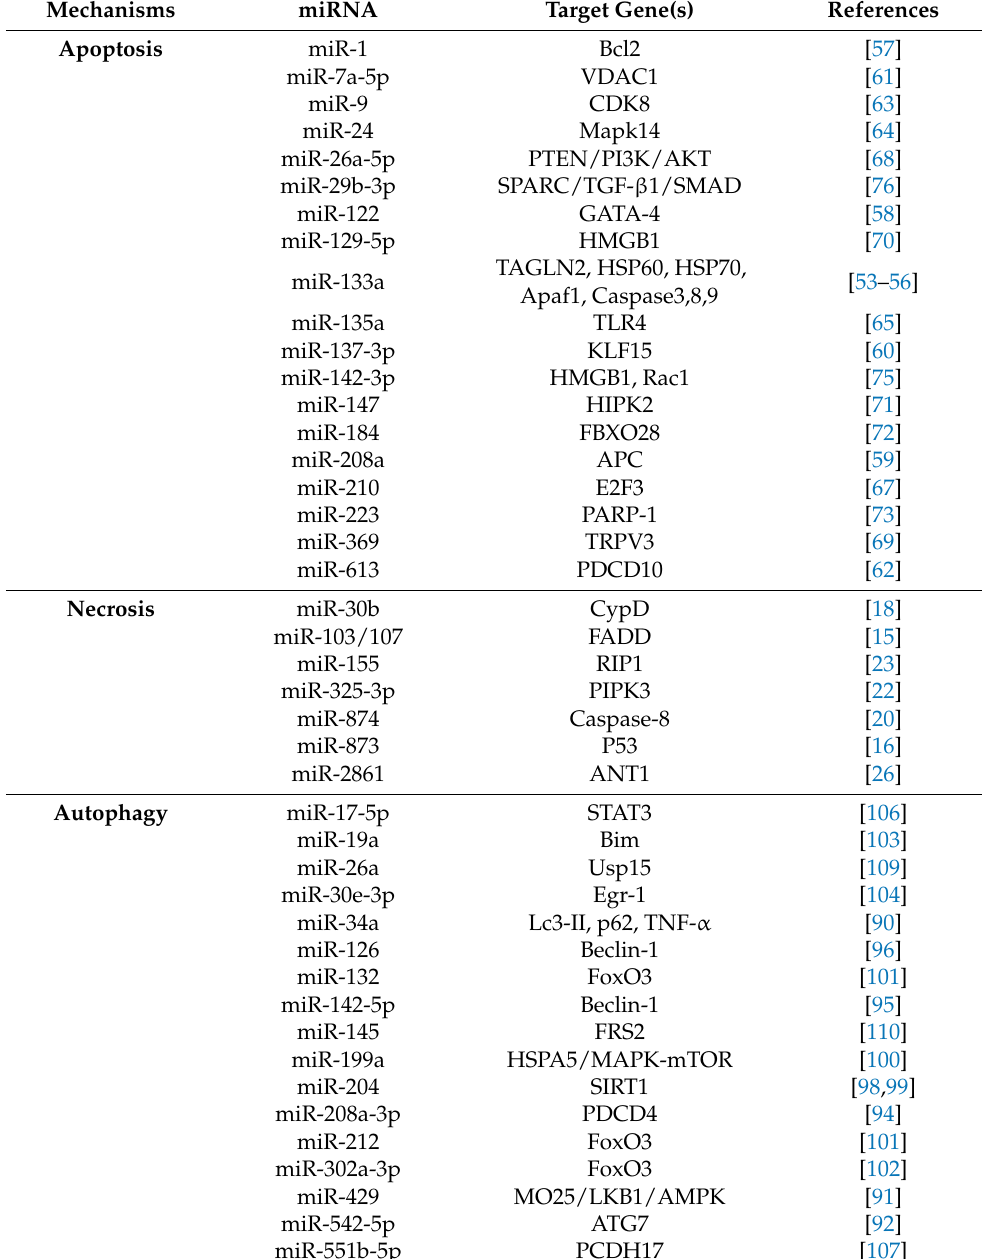
Table 1. Main miRNAs linked to regulation of apoptosis, necrosis, and autophagy in cardiovascular